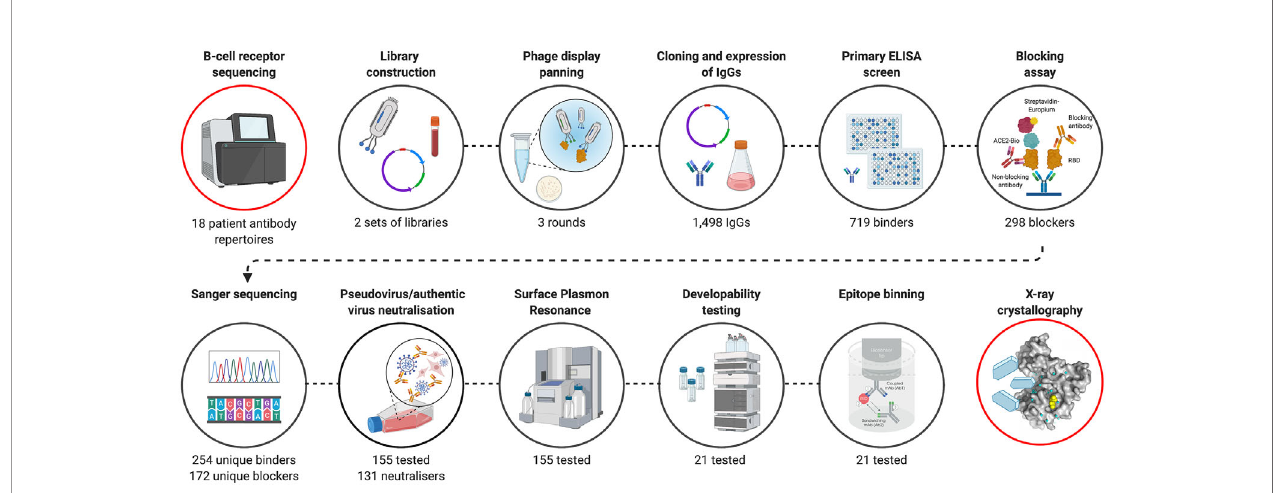
FIGURE 1 | Overview of SARS-CoV-2 antibody discovery and analysis of patient response to COVID-19. Antibody genes isolated from the PBMC ’ s of 18 COVID-19 patients were used to for B cell receptor repertoire sequencing and to construct phage display libraries. Characterization of phage display derived antibodies using high throughput expression, primary binding assay and biochemical ACE-2 receptor blocking assays and DNA sequencing resulted in testing of 155 unique antibodies for pseudovirus neutralization and surface plasmon resonance. A fi nal panel of 21 antibodies were subjected to authentic virus neutralization, epitope binding and developability assessment. Finally, structures of a complementary pair of antibodies with two different mechanism of viral neutralization in complex with RBD were determined using X-ray crystallography. The V H sequences of RBD binding and pseudoviral neutralizing antibodies were co-clustered with whole BCR repertoire sequencing from the patients and published antibodies to understand the nature and dynamics of the early antibody response. Figure was prepared using